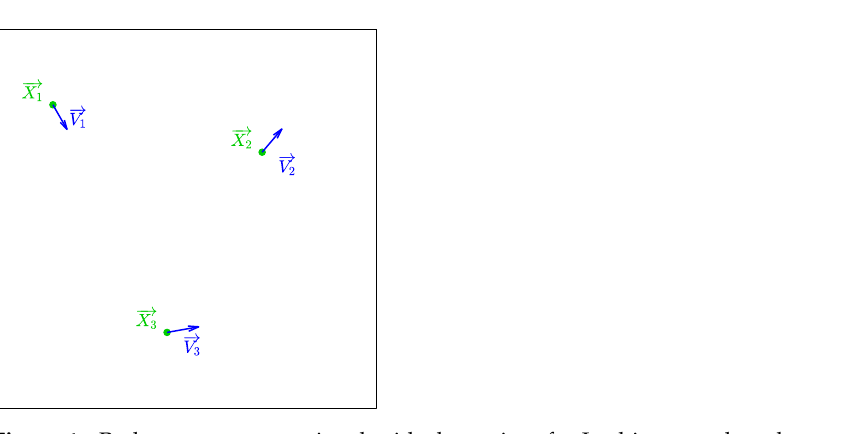
Figure 1. Radar captures associated with three aircraft. In this example only one time sample is